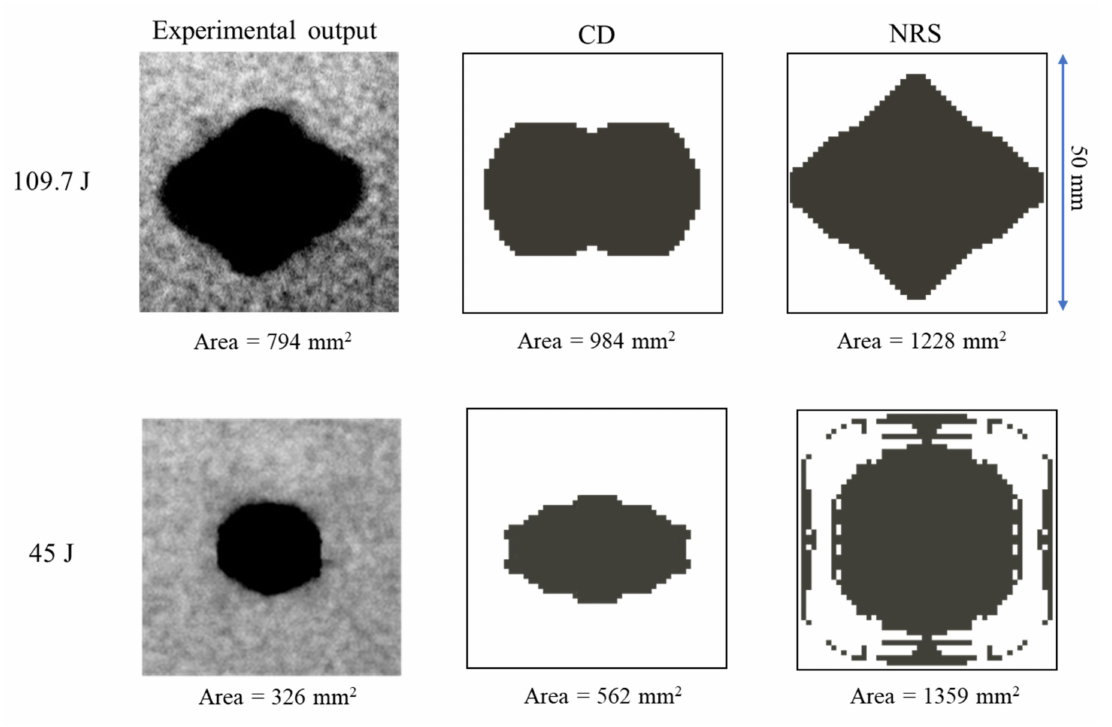
Figure 16. Comparison of experimental and numerical delamination areas for the 109.7 J and 45 J